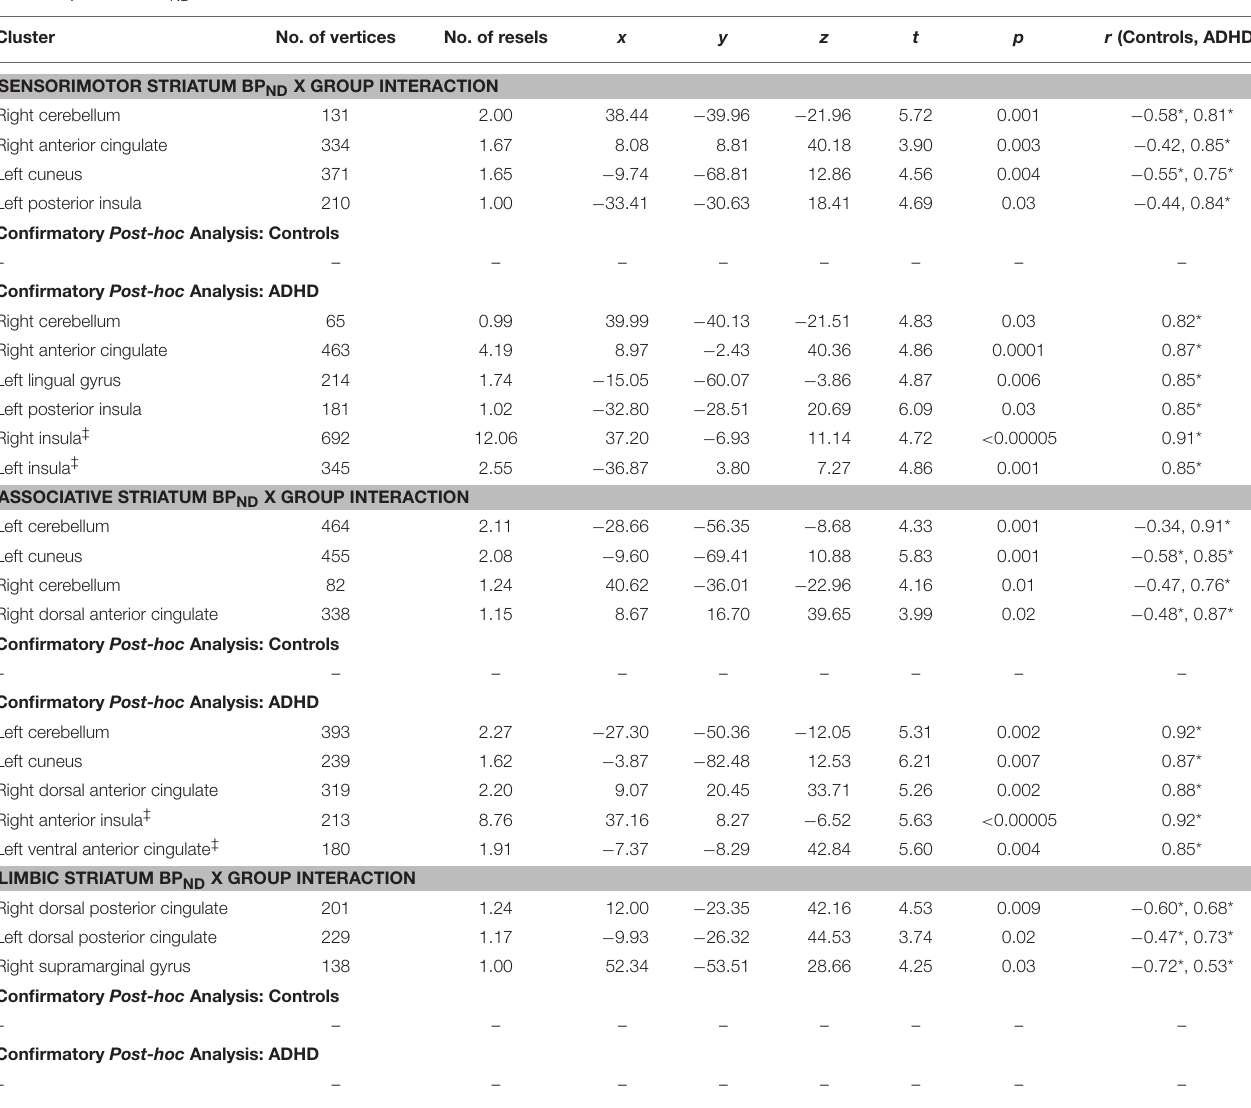
TABLE 4 | Baseline BP ND in relation to cortical thickness.